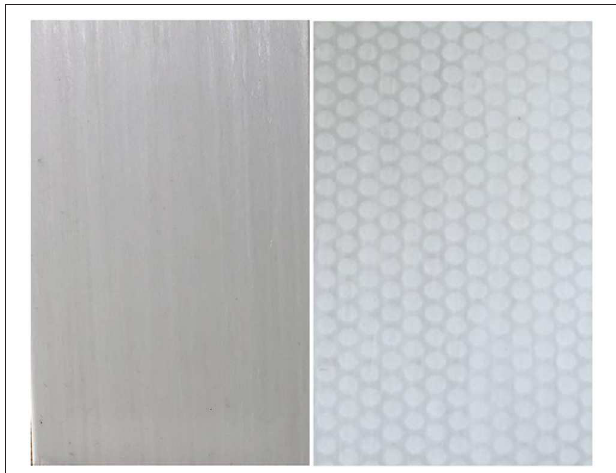
FIGURE 10 | Pultruded ELIUM ® sample before (left) and after (right) embossing treatment by calendaring on the pultrusion line after the